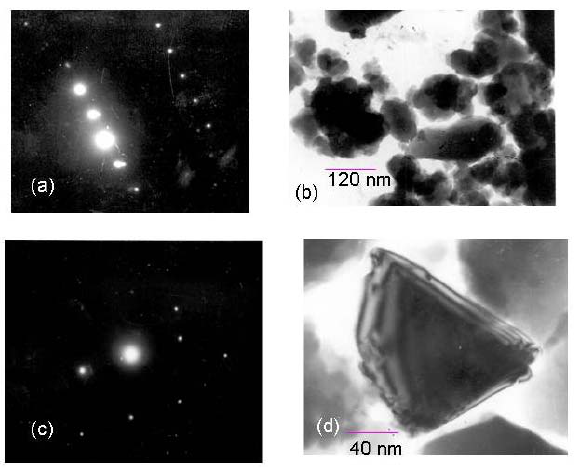
Figure 2. Transmission electron microscopy of palladium-linked ormosil. Diffraction patterns (a) and (c) and their corresponding microstructure (b) and